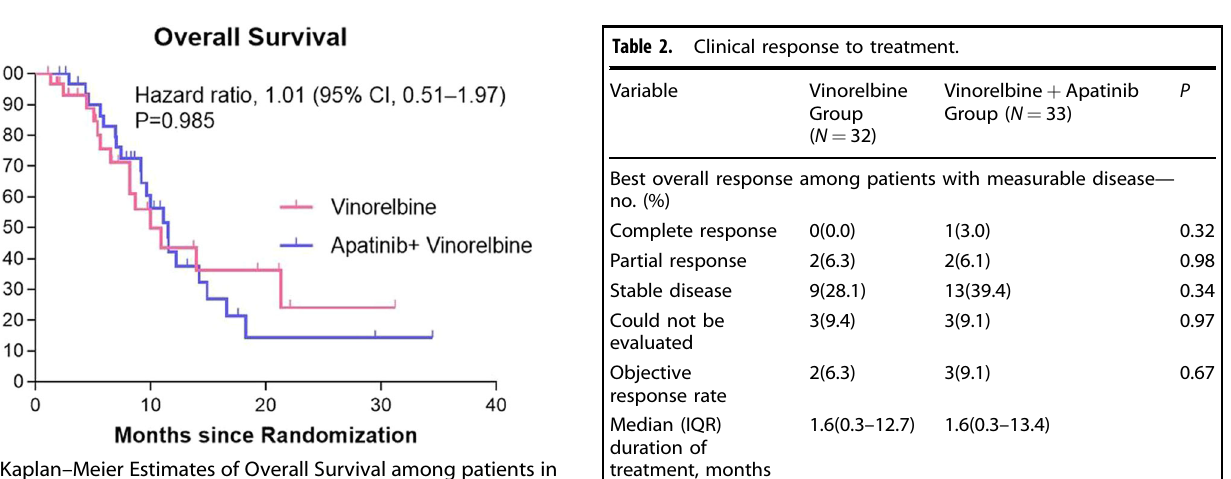
Fig. 3 Subgroup Analysis of Progression-free Survival among patients in the vinorelbine group and apatinib plus vinorelbine group.